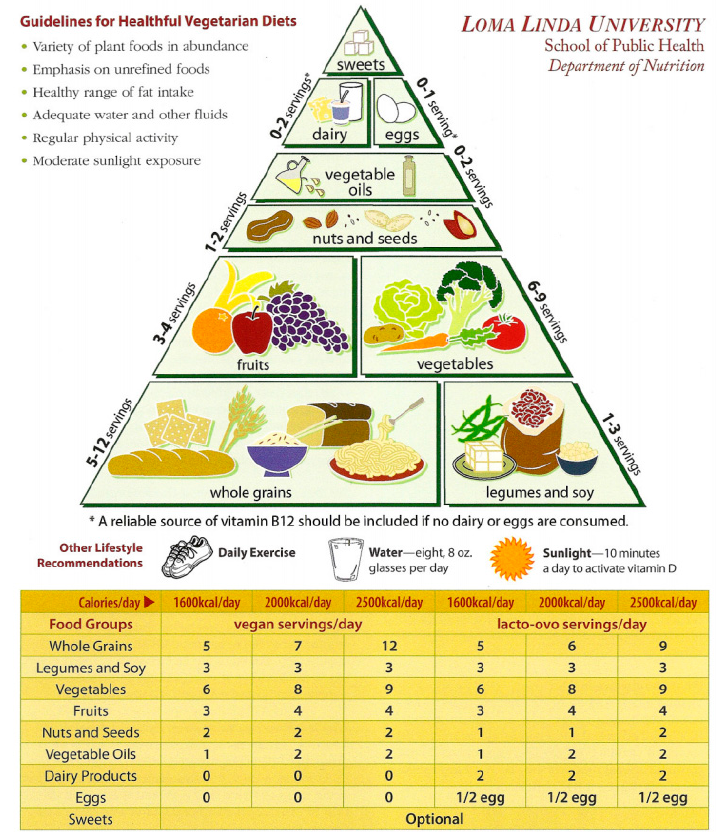
Figure 1. The Vegetarian Food Guide Pyramid Guidelines for Healthful Vegetarian Diets.